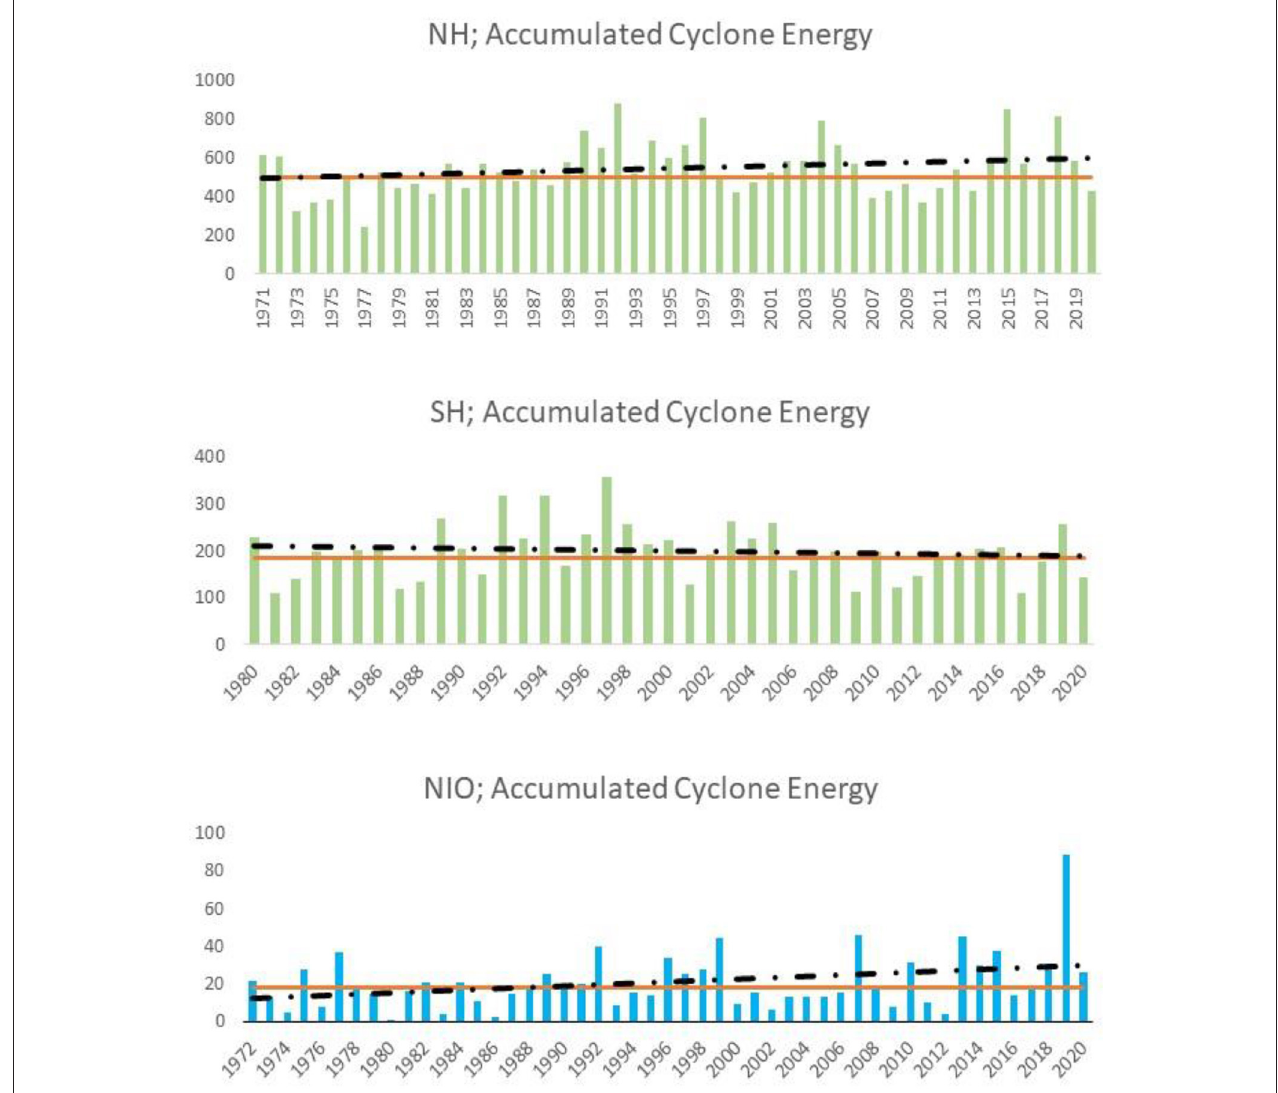
FIGURE 2 | ACE (in 10 4 Knots 2 ) in the Northern and Southern hemispheres and the NIO (black dotted line indicates a linear trend, and orange line indicates significance at 95% confidence level)